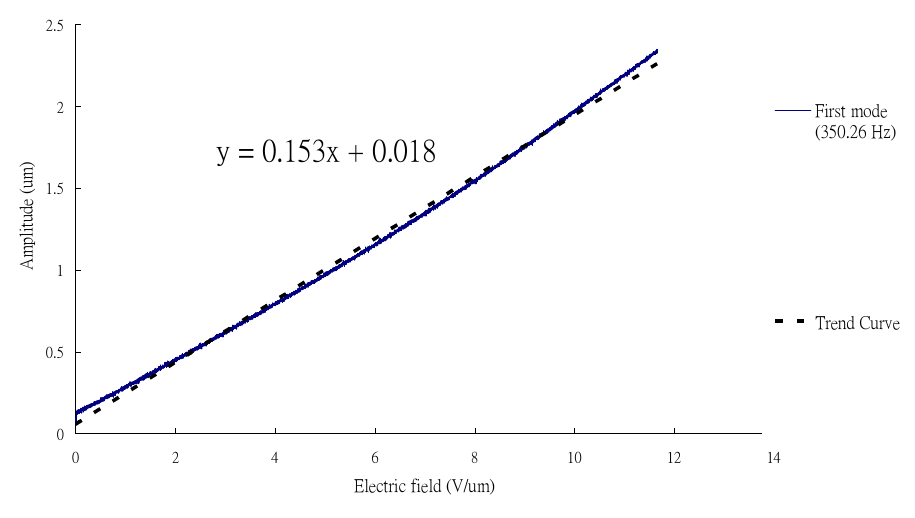
Figure 8. Actuation linearity testing of PZT